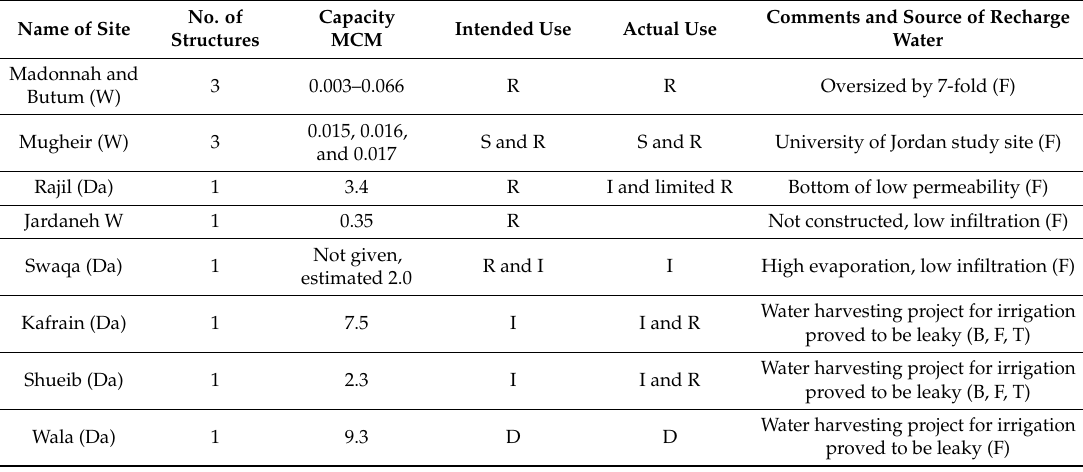
Table 2. Existing and studied (but not yet implemented) managed aquifer recharge projects in Jordan.